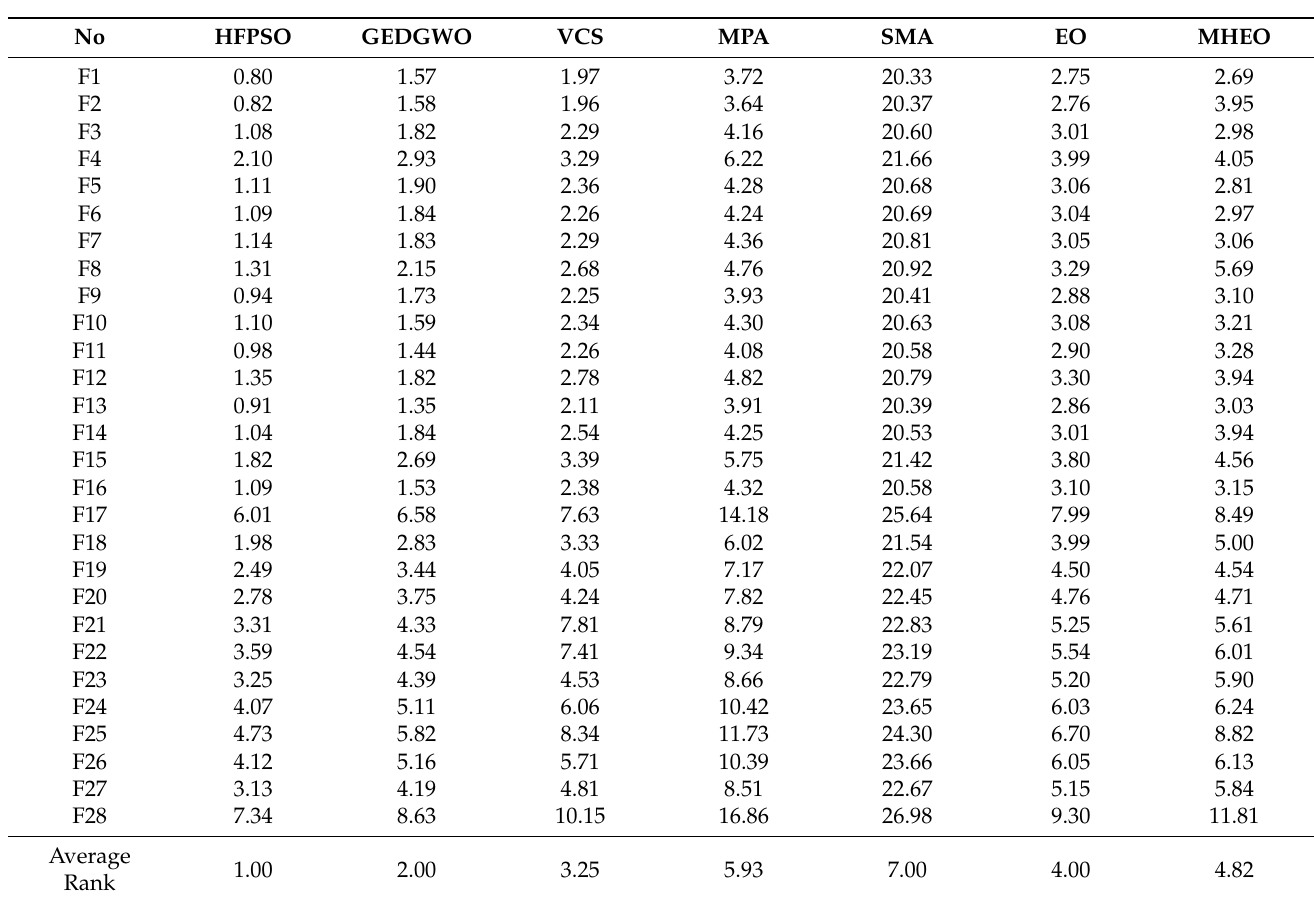
Table A3. Time cost in the CEC2017 30D test (unit: